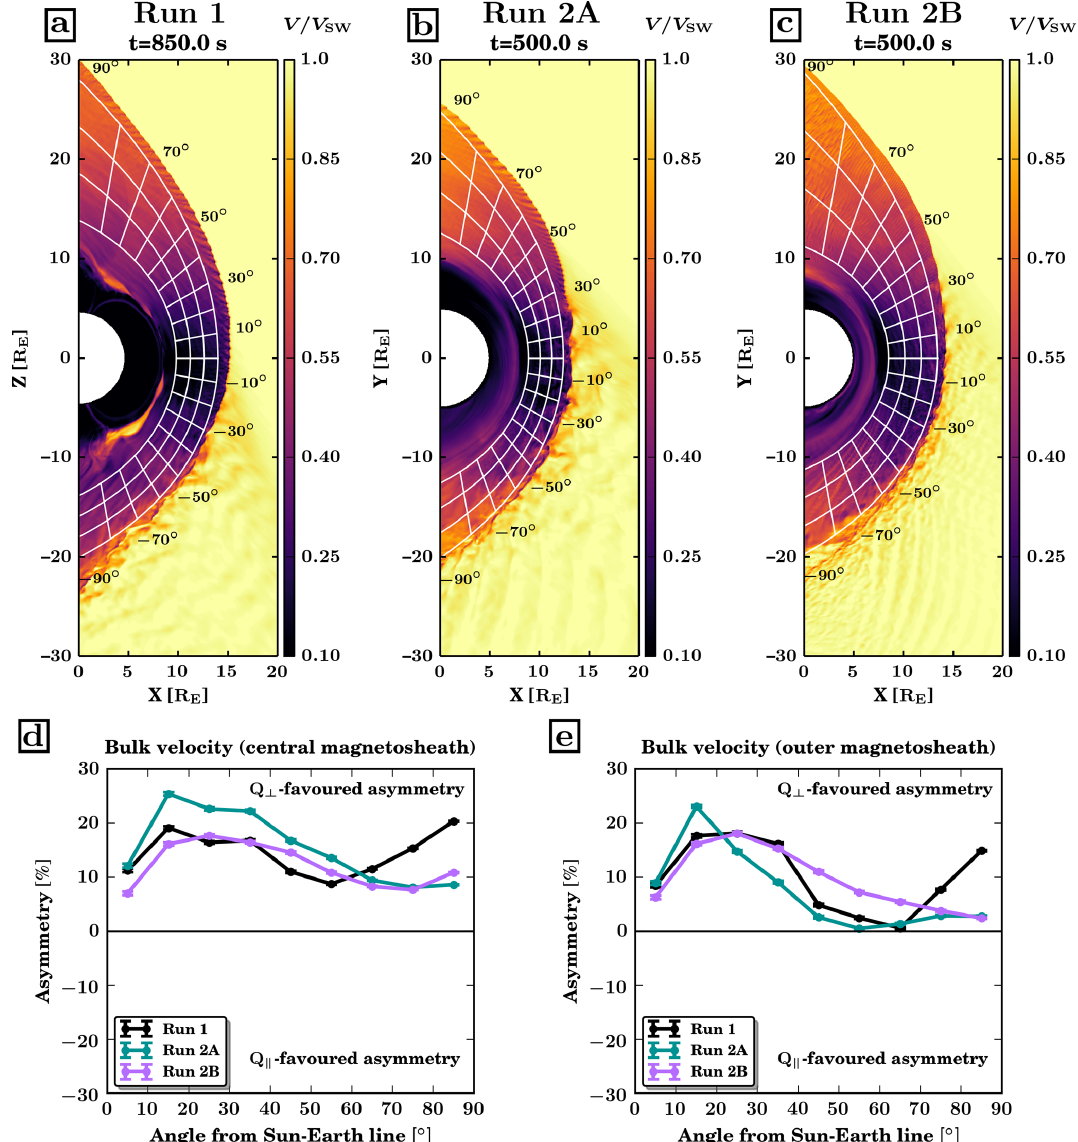
Figure 3. (a–c) Ion bulk velocity in the simulation plane, normalised with the solar wind speed, in Run 1 at time t = 850s (a) and in Run 2A (b) and 2B (c) at time t = 500s. The spatial bins used to calculate the average magnetosheath parameters are shown in white. (d, e) Ion bulk velocity asymmetry in the central (d) and outer (e)